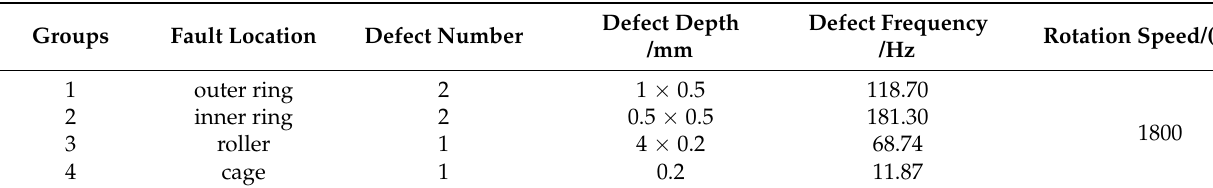
Table 2. Rolling bearing defect information.